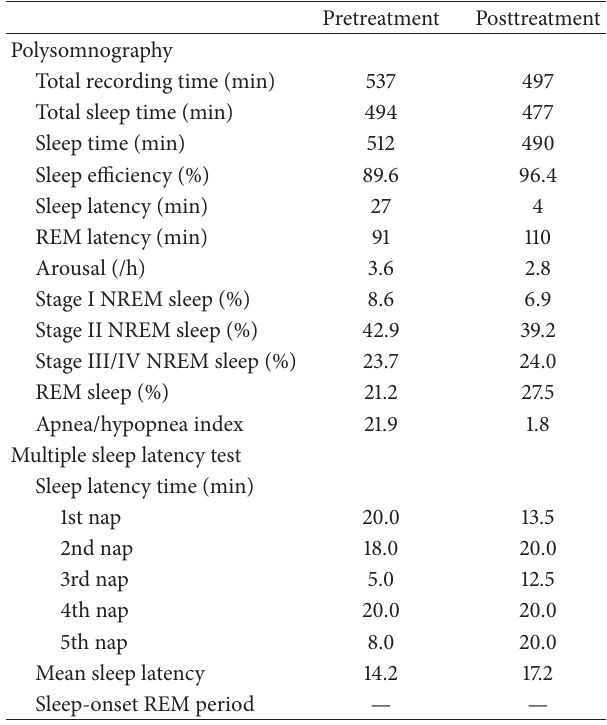
Table 1: Polysomnographic data before and after